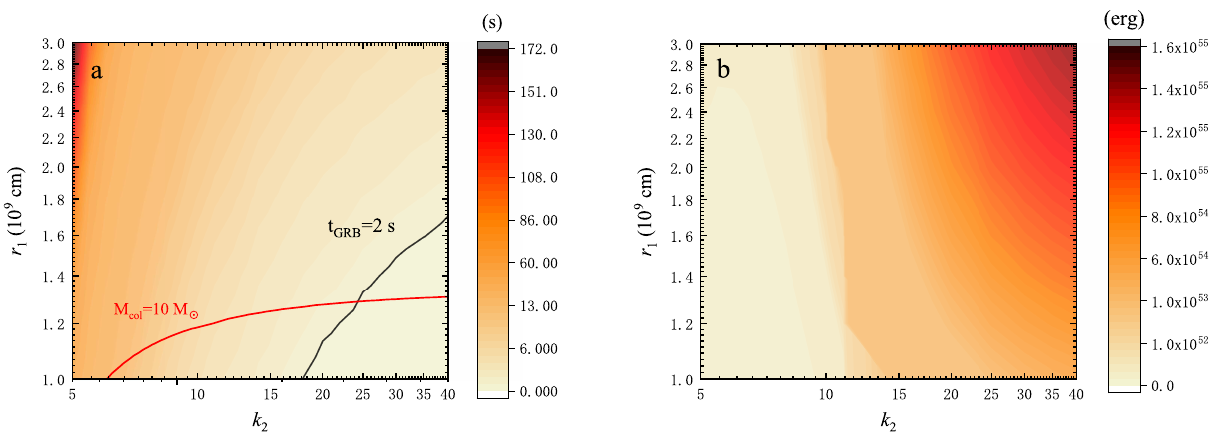
Figure 3. Panel ( a ): GRB duration t GRB as function of r 1 and k 2 for the BZ jet model. Black line corresponds to t GRB = 2 s. Red line corresponds to collapsar mass M col = 10 M (cid:12) . Panel ( b ): isotropic energy E γ ,iso as function of r 1 and k 2 . (adapted with permission from Ref.